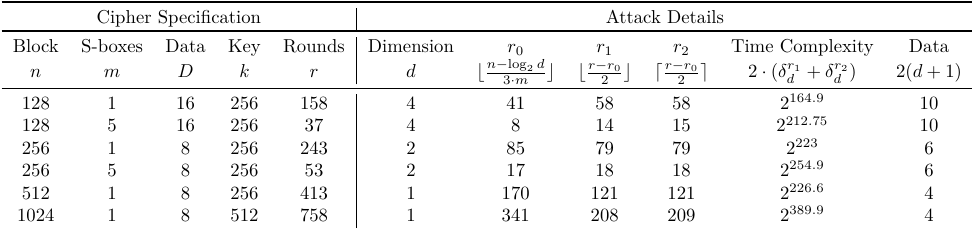
Table 1: Full-round attacks on different versions of LowMCv2. Data is given in number of chosen plaintexts. Block and key size are given in bit.